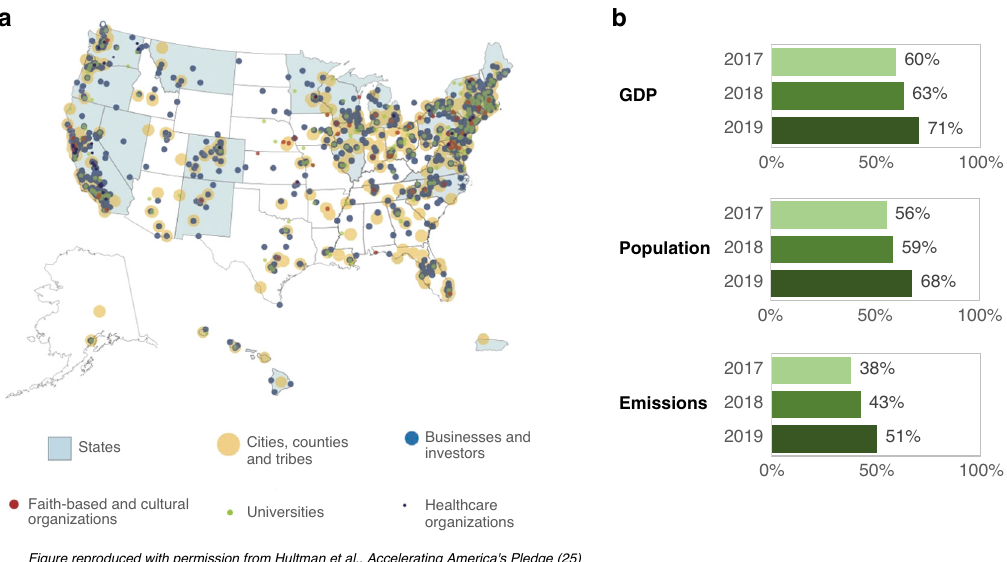
Figure reproduced with permission from Hultman et al., Accelerating America's Pledge (25) Fig. 1 The group of U.S. coalitions of non-federal actors making commitments to climate goals is large, growing, and globally signi fi cant. a States, cities, businesses, universities, faith-based, and other organizations now number greater than 3800 24 . This study assessed the most signi fi cant subset of the actors shown in the map, focusing on states and the 285 largest cities. b Growth of the coalition from 2017 – 19, now representing the equivalent of the world ′ s second-largest economy (after the entire United